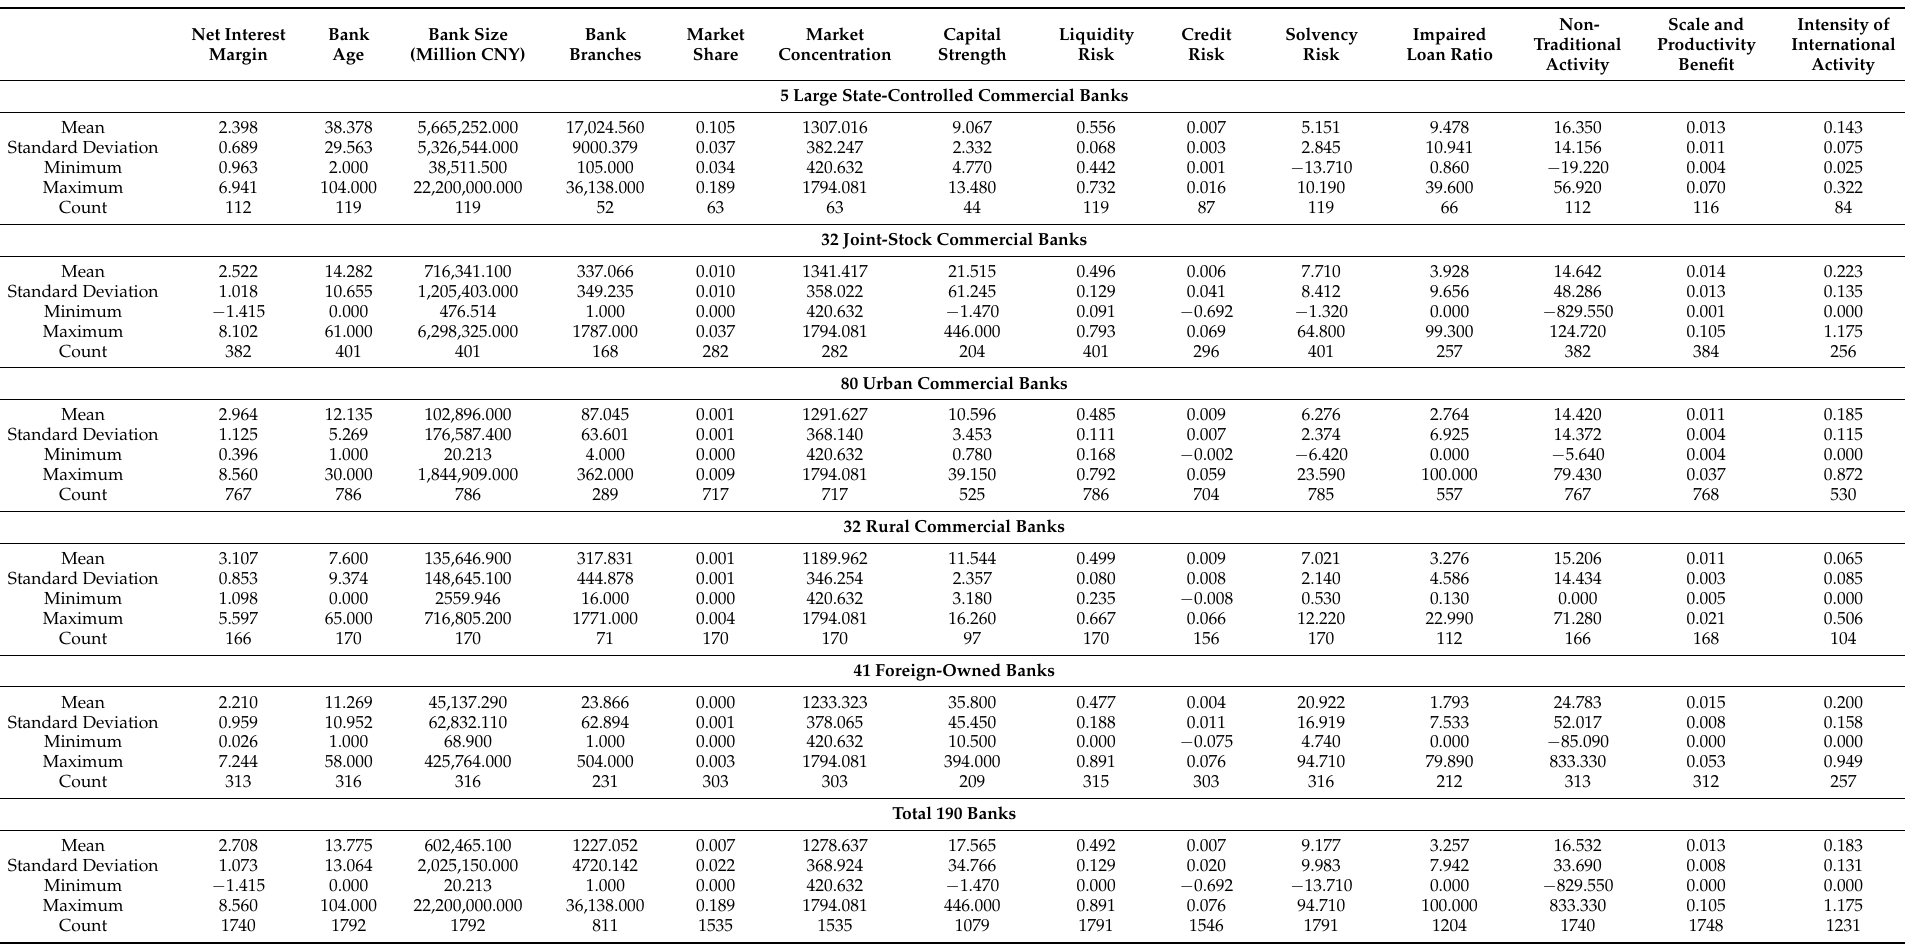
Table 2. Group Summary